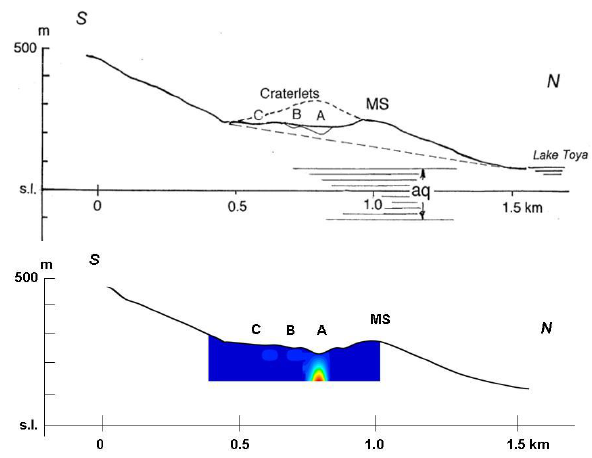
Fig. 8. 2 Fig. 8. A topographic profile in a south–north direction passing MS 3 hill and the craterlets. “aq” indicates the aquifer observed at well GSH-1 (Fig. 5) (upper). Density projection as calculated from the result of muon radiography